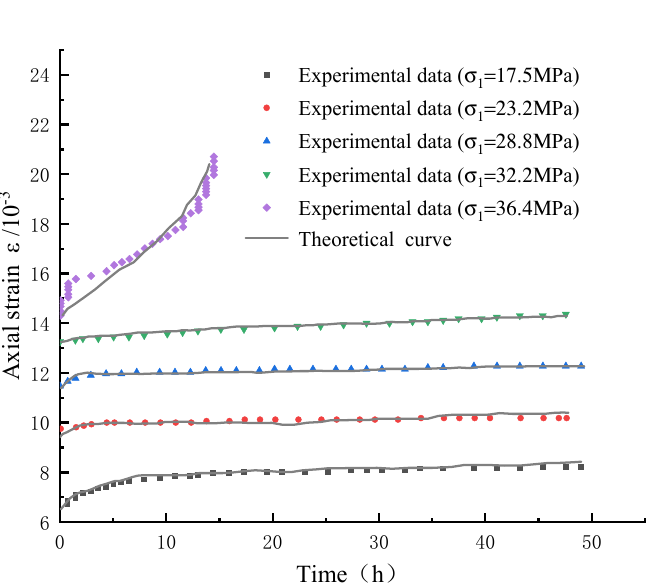
Figure 3. Comparison of rock creep experimental curve and constitutive curve considering chemical damage. Table 1. Sandstone triaxial creep model parameters considering chemical damage (initial pH = 3).